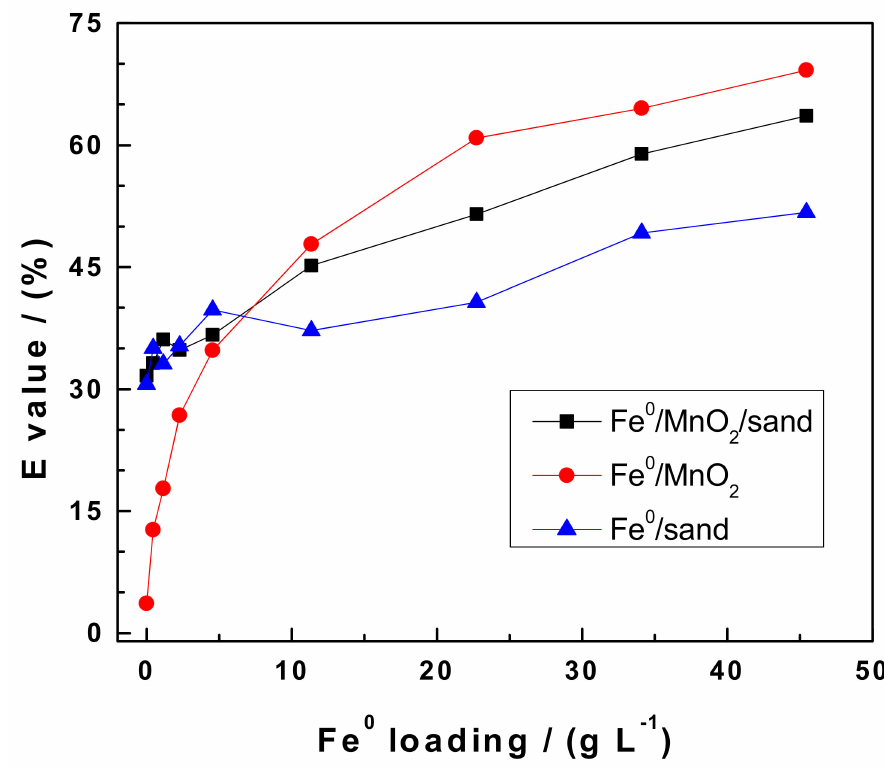
Figure 2. Methylene blue discoloration in Fe 0 /sand/MnO 2 systems as impacted by the addition of various Fe 0 loading for 7 days. Experimental conditions: [Fe 0 ] = 2.3 to 45 g L − 1; [sand] = 45 g L − 1; and [MnO 2 ] = 2.3 g L − 1, shaken intensity: 75 rpm. The lines are not fitting functions, they simply connect points to facilitate